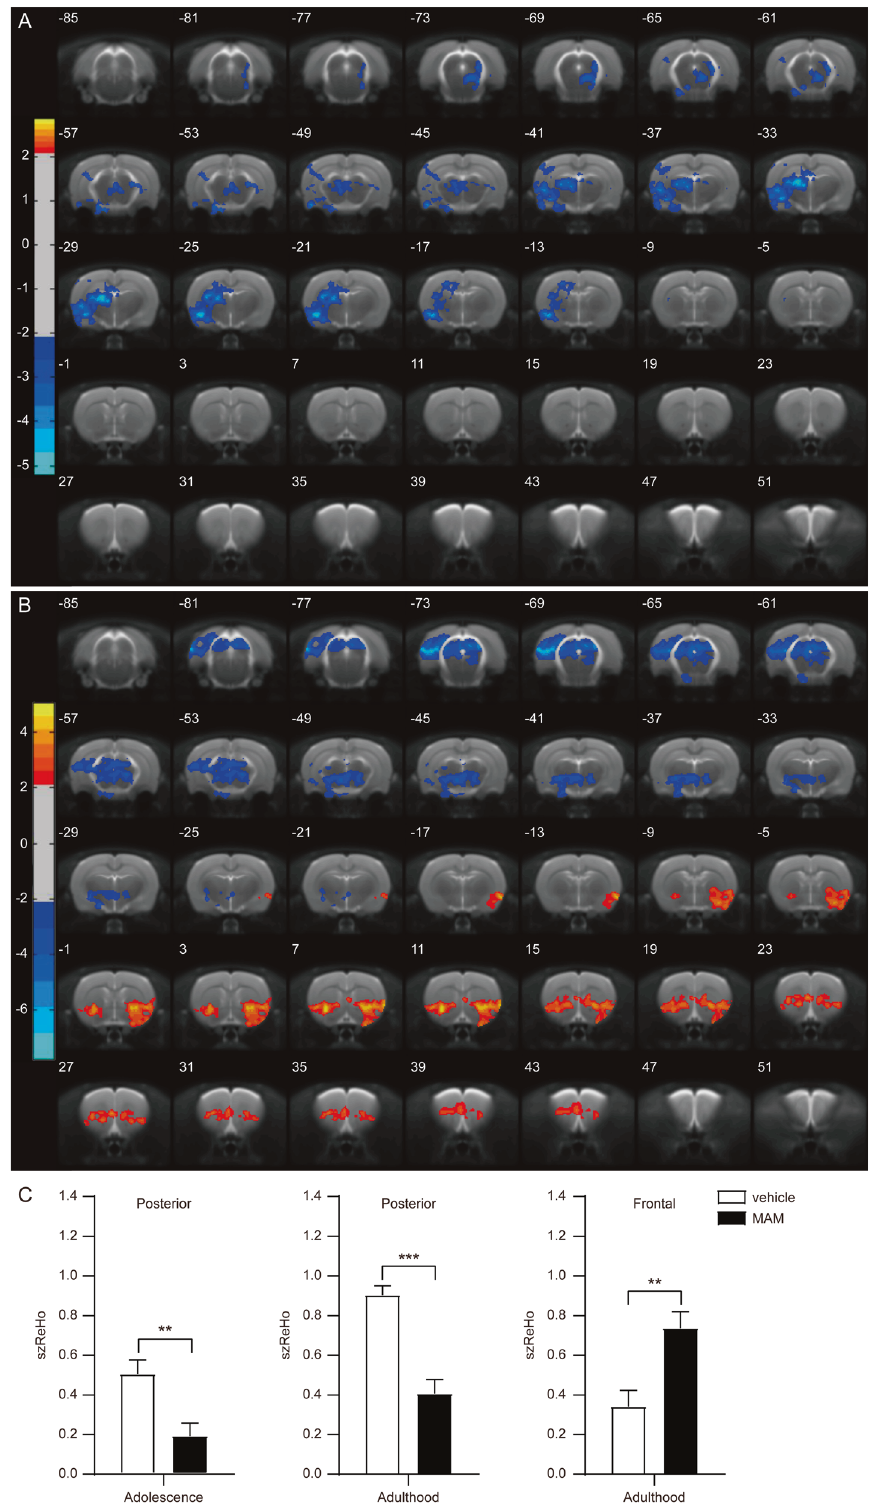
from the overlaps between the frontal and posterior ROIs and the signi fi cant clusters identi fi ed in the longitudinal analysis of MAM rats. Compared to vehicle rats, MAM rats had signi fi cantly decreased ReHo value within the posterior overlap in adolescence ( T = − 3.241, P = 0.004) (Fig. 3C). In adulthood, ReHo value was